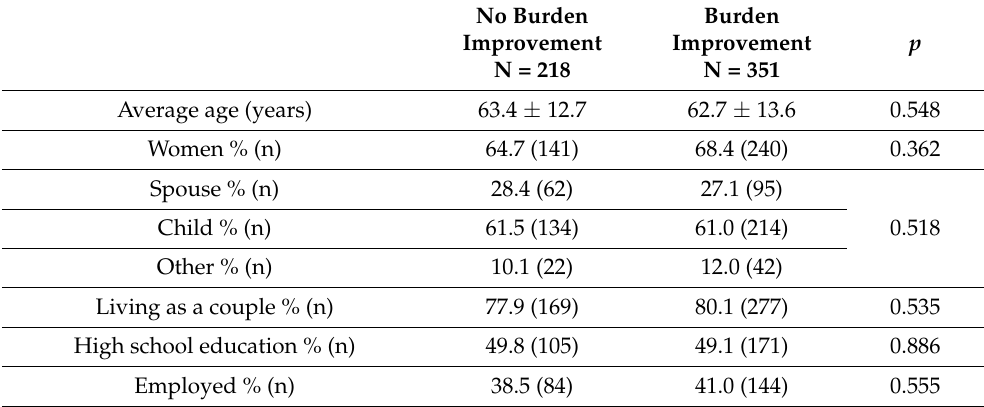
Table 4. Evolution of the profile of FCGs according to the improvement of their burden. No